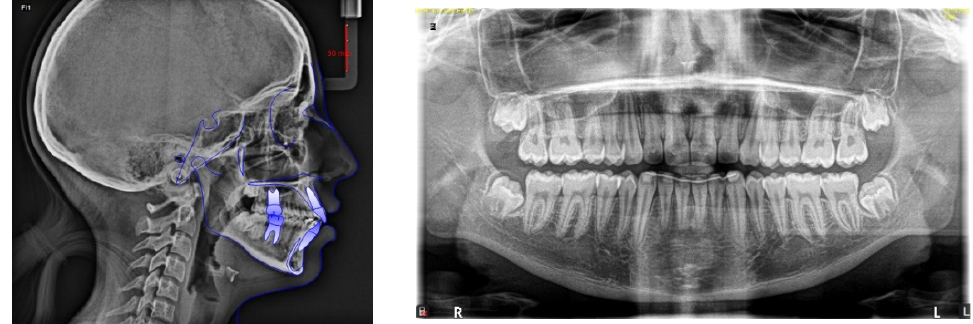
Figure 15. Post-treatment lateral cephalogram and panoramic radiograph.